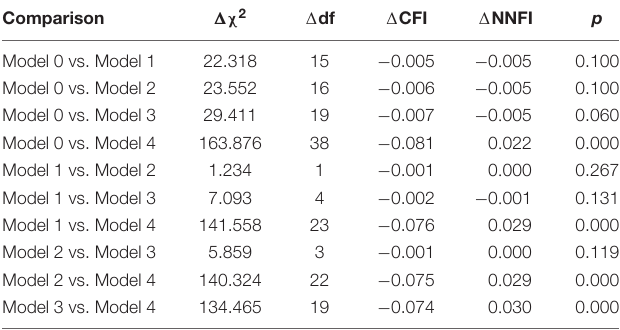
TABLE 8 | Model comparisons for multigroup Structural Equation